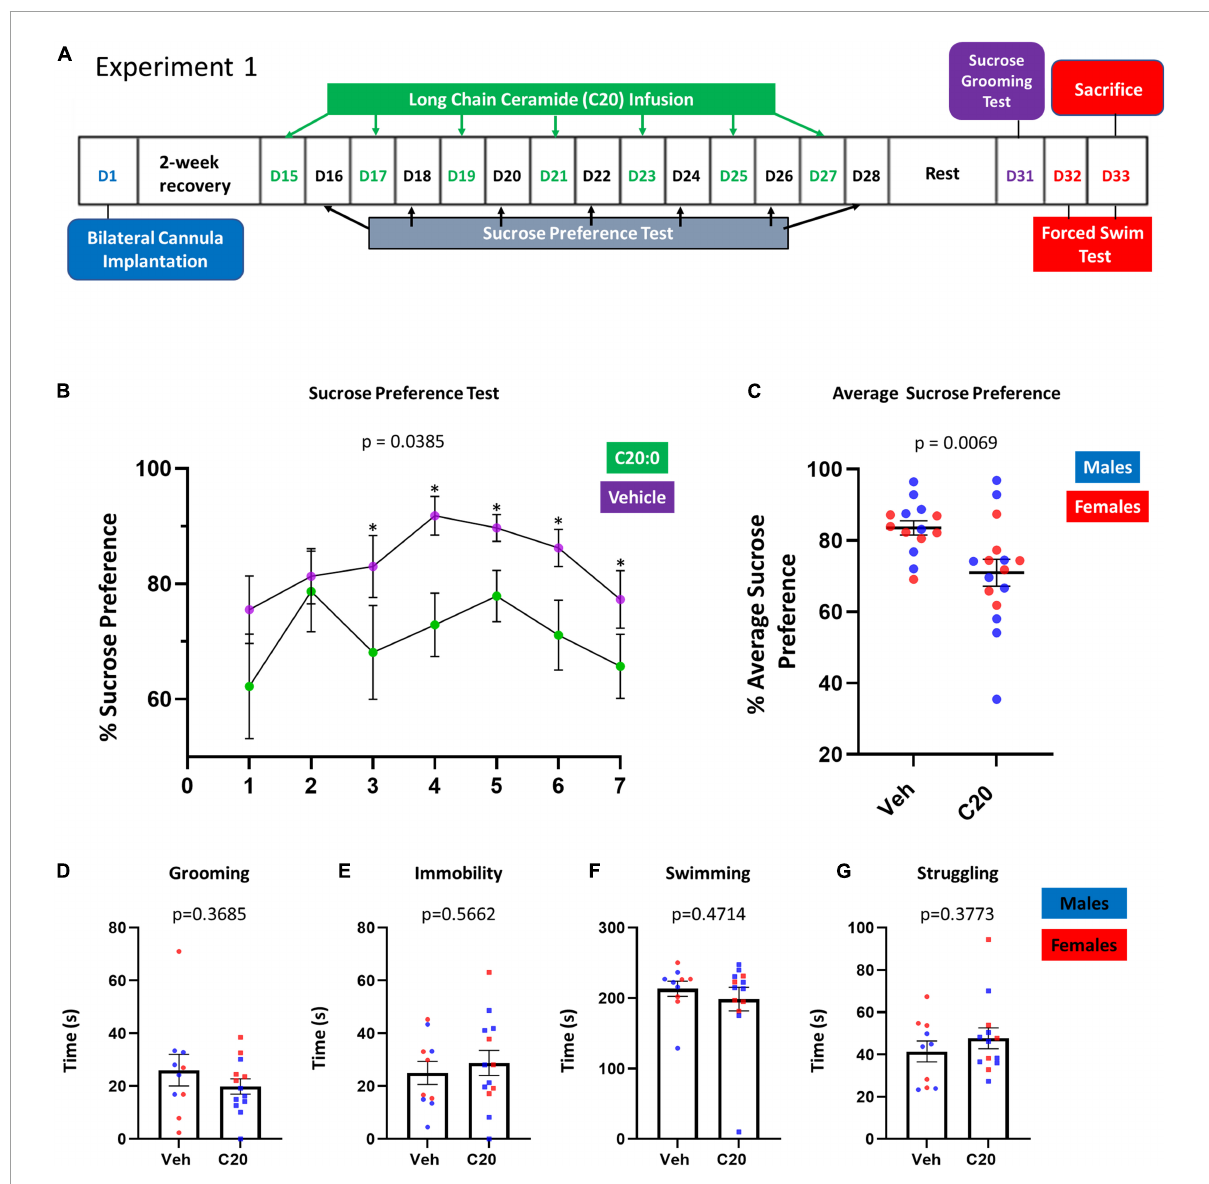
FIGURE1 Experimental approach. Long-chain C20:0 ceramide infusions into the VH induced anhedonia-like behavior in male and female rats. (A) Timeline of the bilateral cannula implantation, 7–C20:0 ceramide infusions every other day (green font), and intercalated sucrose preference tests 24 h after every infusion (black font). D = day as indicated in the experimental timeline. (B) Results of 7 sucrose preference tests given the day after each C20:0 ceramide infusion. (C) Average sucrose preference across the 7 sucrose preference tests. (D) Sucrose grooming time during 5 min on day 31. (E–G) Immobility, swimming, and struggling time measured in the forced swim test to assess despair-like behavior on day 33. n = 14 in vehicle group and n = 16 in ceramide group. Males in blue symbols and females in red symbols. The symbol ∗ denotes statistical difference, p < 0.05.